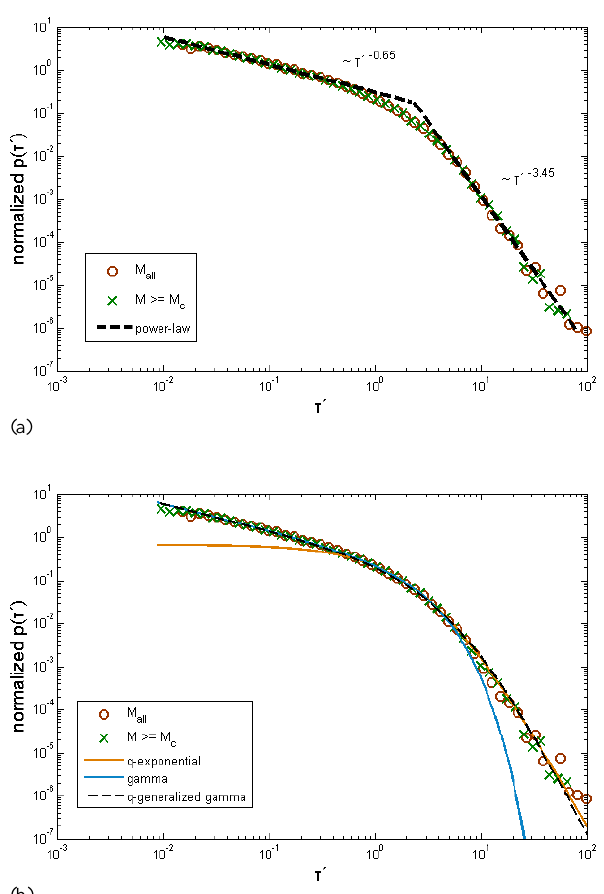
Figure 7: Normalized probability density p ( τ ΄) for the scaled inter-event times τ ΄. a) 5 Fig. 7. Normalized probability density p(τ 0 ) for the scaled in- terevent times τ 0 . (a) Power-law fit. (b) The fitted curves that Power-law fit. b) The fitted curves that correspond to the q -exponential (Eq. (25)) for 6 correspond to the q -exponential (Eq. 25) for the values of Z q = the values of Z q =1.47, B =1.34 and q =1.23, gamma (Eq. (31)) for the values of 7 1 . 47, B = 1 . 34, and q = 1 . 23, gamma (Eq. 31) for the values of C =0.35, γ =0.39, β =1.97 and q -generalized gamma distribution (Eq. (32)) for the 8 C = 0 . 35, γ = 0 . 39, β = 1 . 97, and q -generalized gamma distribu- values of C =0.35, γ =0.39, θ =1.55 and q =1.23. 9 tion (Eq. 32) for the values of C = 0 . 35, γ = 0 . 39, θ = 1 . 55, and q = 1 .